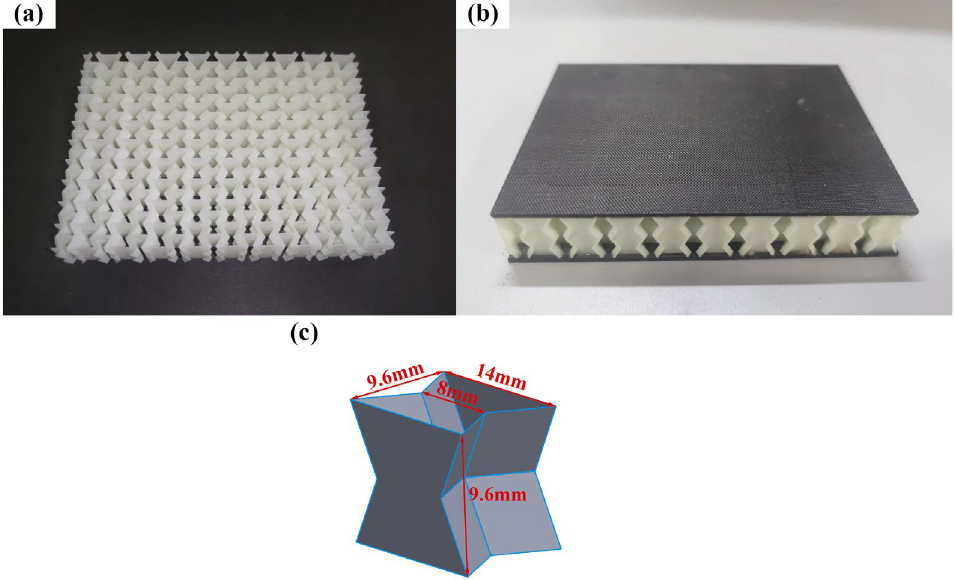
Figure 3. Re-entrant honeycomb sandwich panel. ( a ) core; ( b ) specimen; ( c ) a unit cell. Table 1. Mechanical parameters of T300/7901 laminates [41].